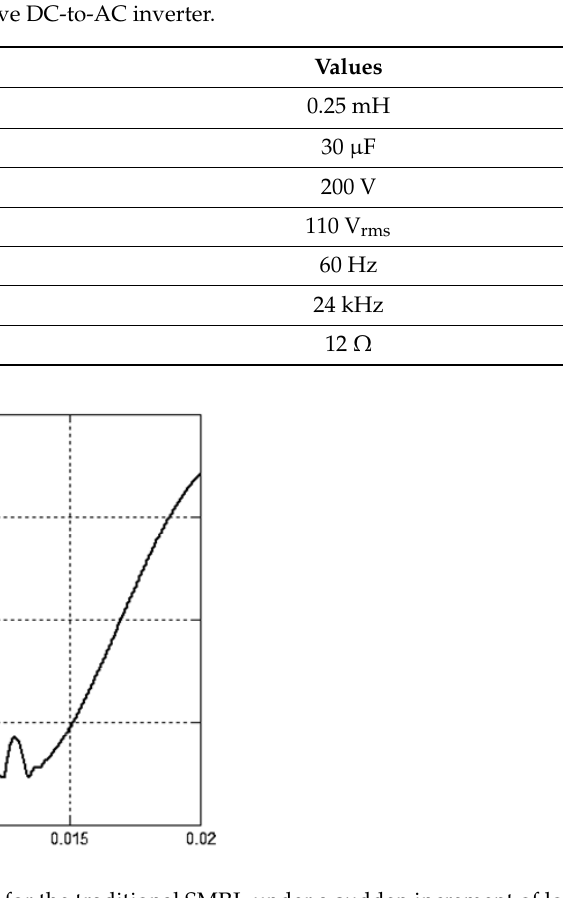
Figure 5. Simulated AC output voltage for the traditional SMRL under a sudden increment of